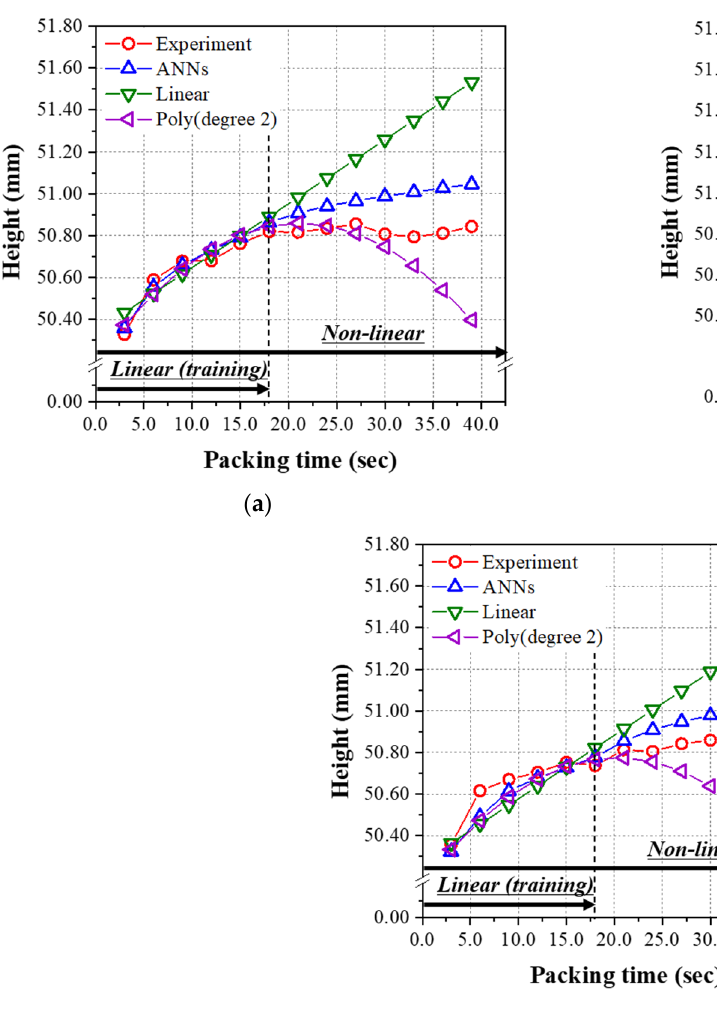
Table 11. Optimized hyper-parameters for the nonlinear relationship group (packing time was 3.0~39.0 s).